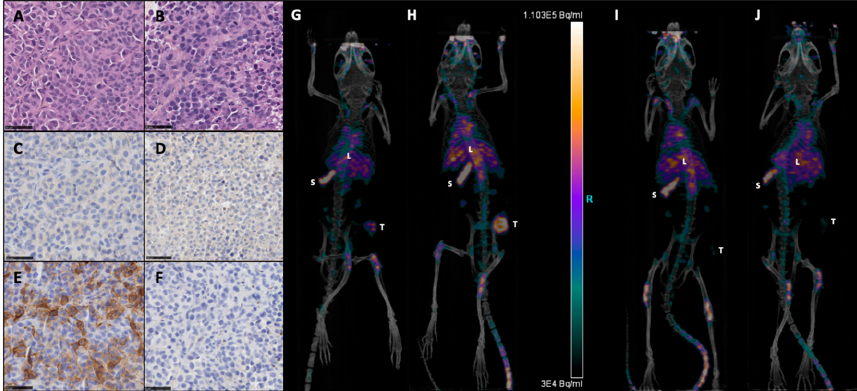
Figure 1. Expression of programmed death-ligand 1, B7-H1, CD274 (PD-L1) on M113 melanoma xenograft tumors. For- malin-fixed and paraffin-embedded histologic sections of M113 PD-L1+ ( A , C , E ) and M113 WT ( B , D , F ) melanoma xenograft tu- mors were examined immunohistochemically after hematoxylin and eosin ( A , B ), rabbit isotype control ( C , D ), and anti- hPD-L1 ( E , F ) staining. All sections were photographed at 40x original magnification, scale bars = 50 μ m. Data are repre- sentative of 4 different M113 PD-L1+ and M113 WT tumors. Immuno-PET imaging of mice bearing subcutaneous M113 PD-L1+ ( G , H ) or M113 WT ( I , J ) tumors at 1 ( G , I ) or 2 weeks ( H , J ) after tumor engraftment and 48 h after injection of 10 MBq 64 Cu- anti-hPD-L1mAb (L: liver, S: spleen, T: tumor). Data are representative of 3 different mice in each group.